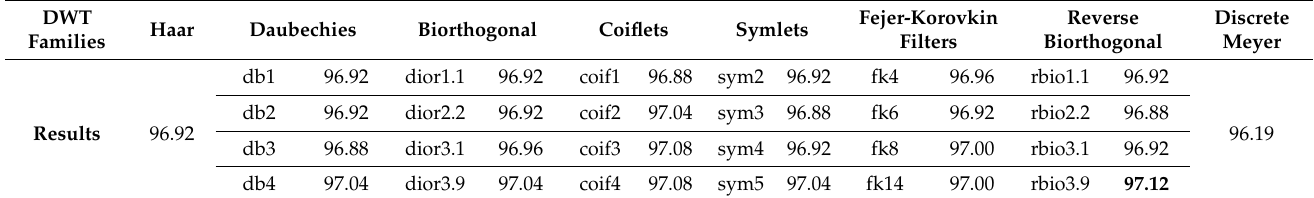
Table 5. Identification accuracies using several DWT families applied to the CASIA database.